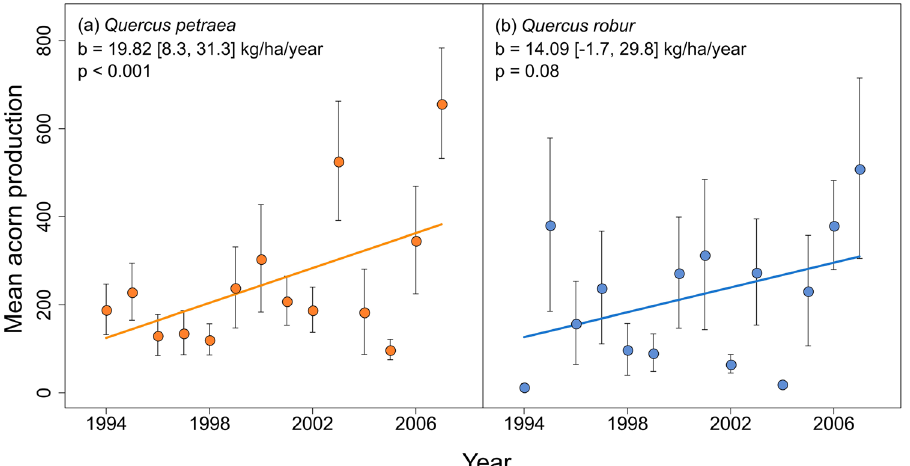
Figure 1. Temporal variation in seed production for Quercus petraea and Quercus robur . Temporal variation in seed production (kg/ha) of 19 and 9 populations of Q . petraea ( a ) and Q . robur ( b ) respectively, monitored over 14 years and distributed throughout France. Each dot corresponds to the mean seed production across all populations per year (kilograms per hectare per year averaged over all sites), the standard errors are indicated for each dot. The slope of the regression line and its 95% confidence interval, calculated from a linear mixed- effects model [2], are given for both species, with the coefficient of determination ( R 2 ) between model [2] and mean production.